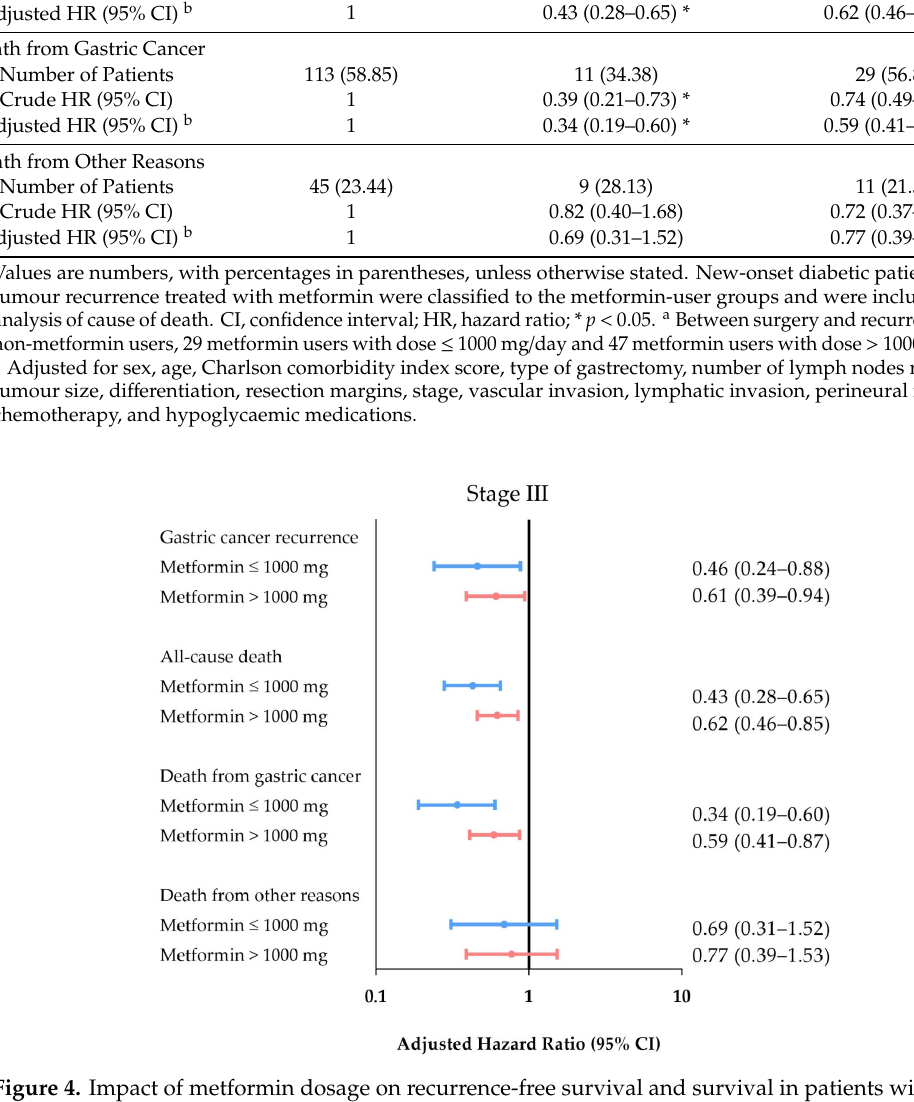
Figure 4. Impact of metformin dosage on recurrence-free survival and survival in patients with stage III GC and DM.